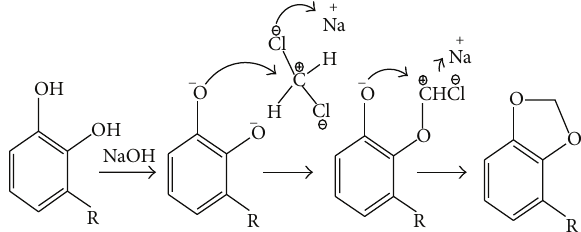
Figure 1: Aldolization mechanism of synthesis of urushiol methy- lene acetal.